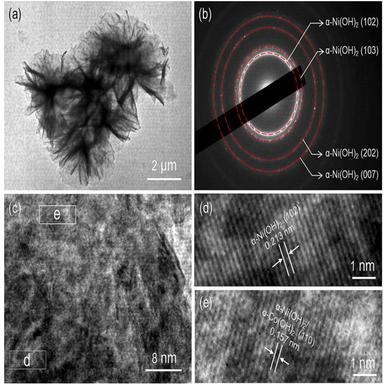
(a) TEM image and (b) SAED pattern of CoNi LDH NFs, and (c-e) HRTEM images of the CoNi LDH NFs.